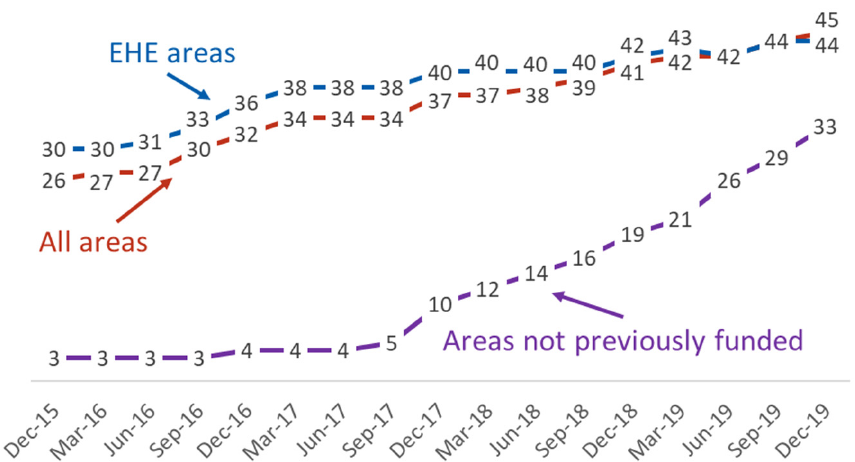
Figure 1. Sequence completeness (percentage of diagnoses in the past 3 years with an HIV sequence available), by quarterly dataset, in Ending the HIV Epidemic (EHE) priority areas, all areas, and areas not previously funded to collect sequence data before 2018.